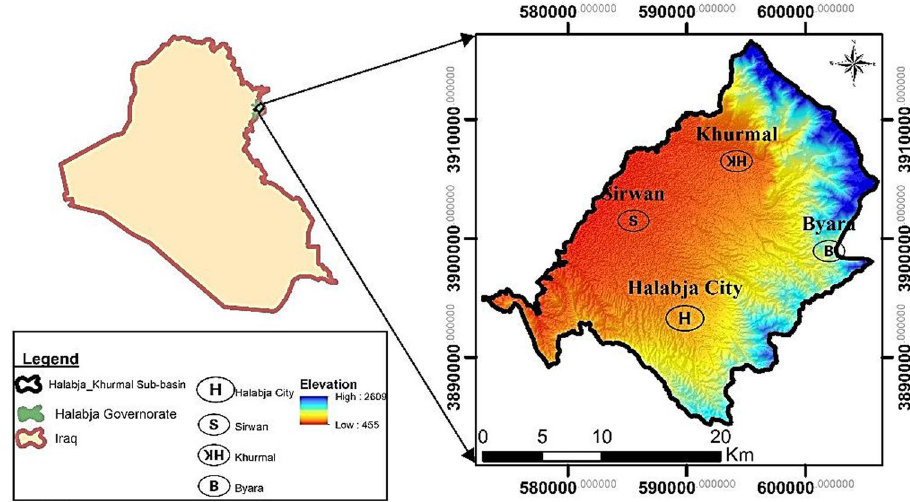
Fig. 1 Location map of the Halabja-Khurmal